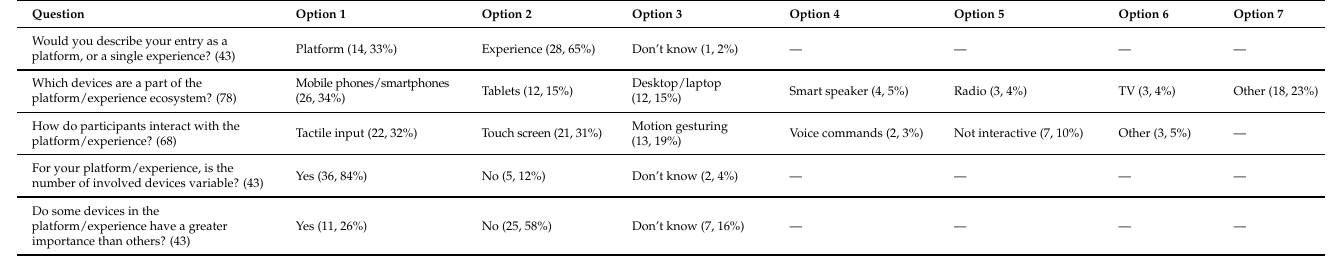
Table A1. Multiple choice questions and responses for the multi-device audio experiences and technologies survey. The numbers and percentages of responses are given in parentheses.